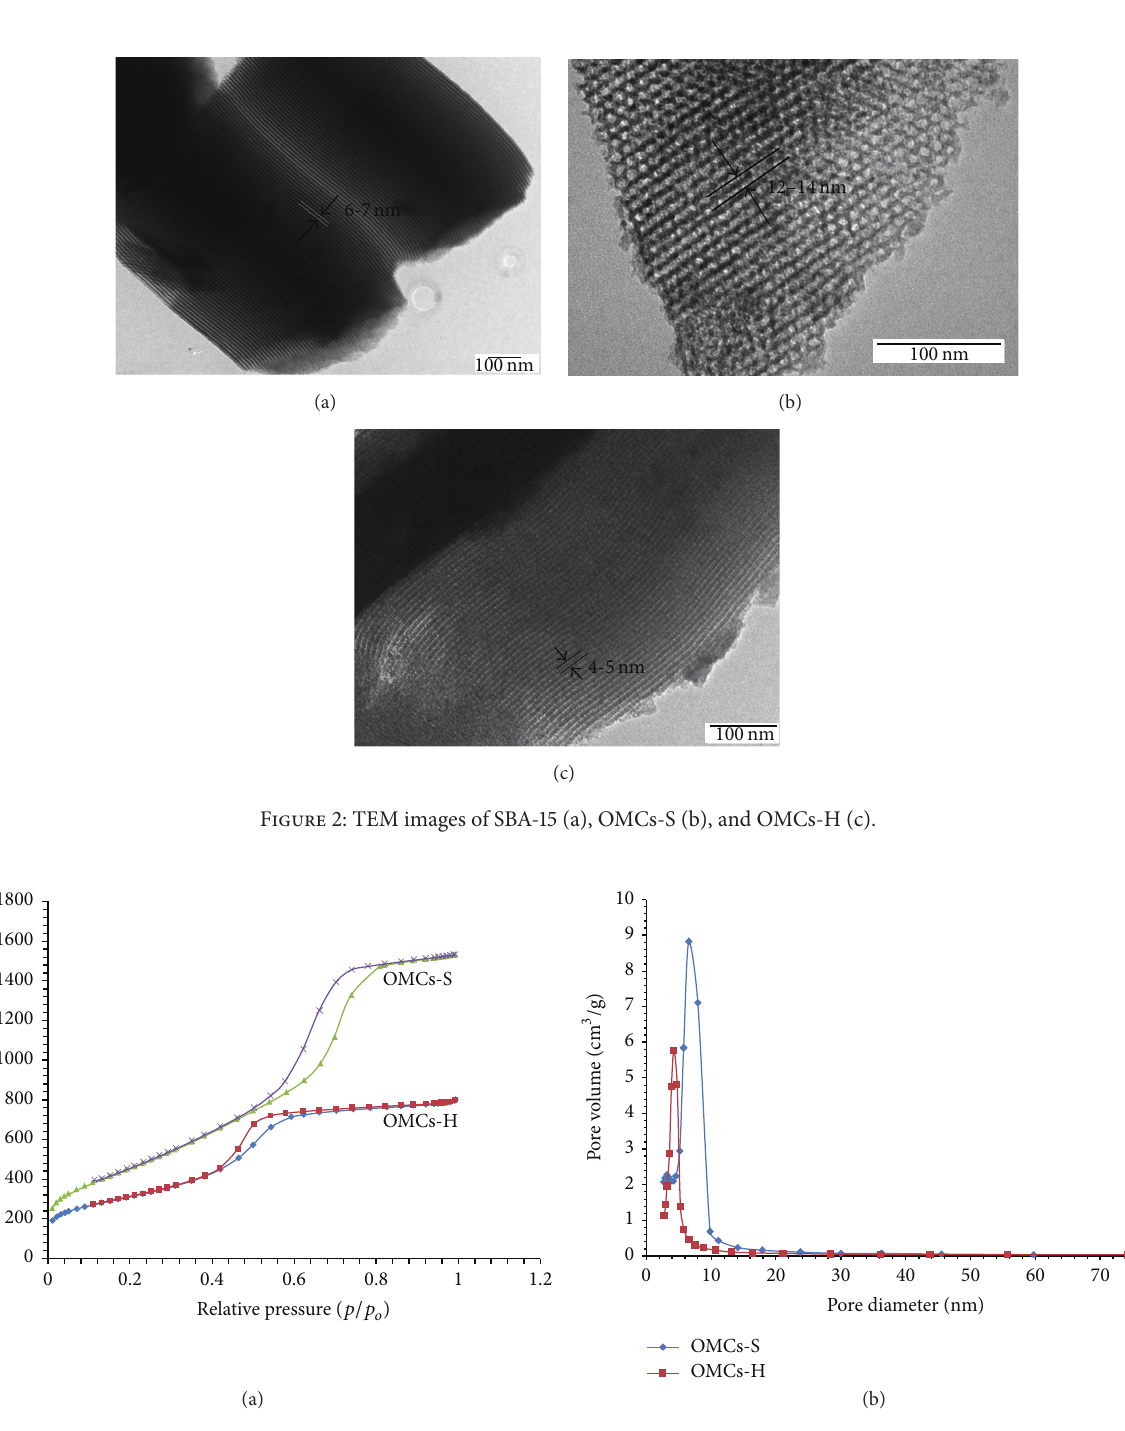
Figure 3: N 2 adsorption-desorption isotherms (a) and pore-size distribution (b) of OMCs-H and OMCs-S.